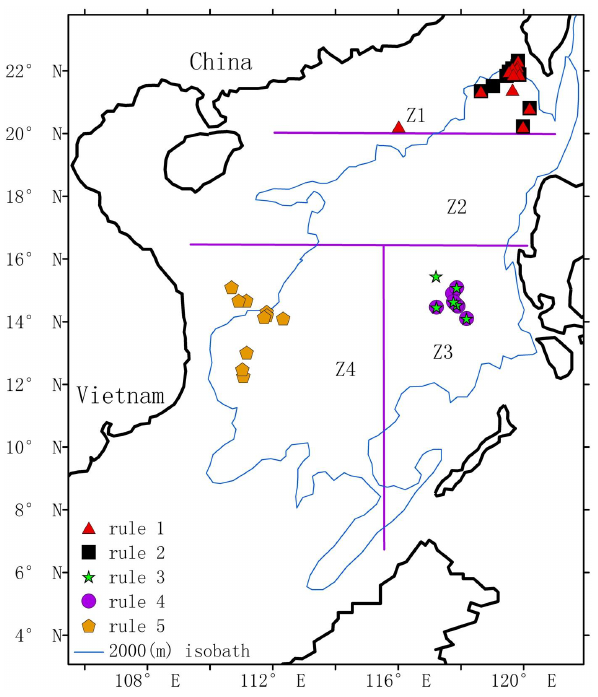
Fig. 6. Spatial distribution of typical mesoscale-eddy states in the SCS extracted from Table 5. (Blue line is 2000m